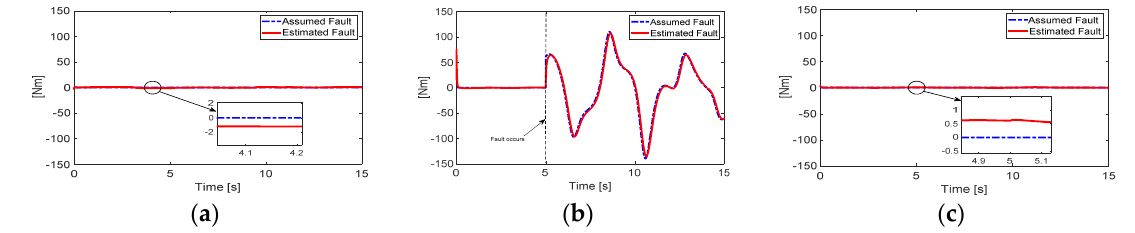
Figure 3. Fault estimation results with a single fault at Joint 2. ( a ) Joint 1; ( b ) Joint 2; ( c ) Joint 3.